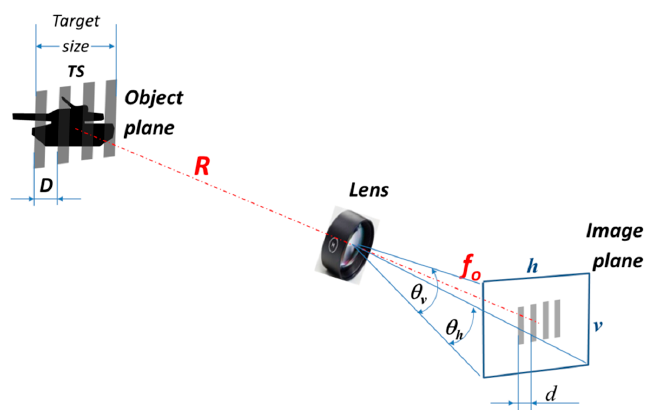
Figure 4. Spatial frequency concept.